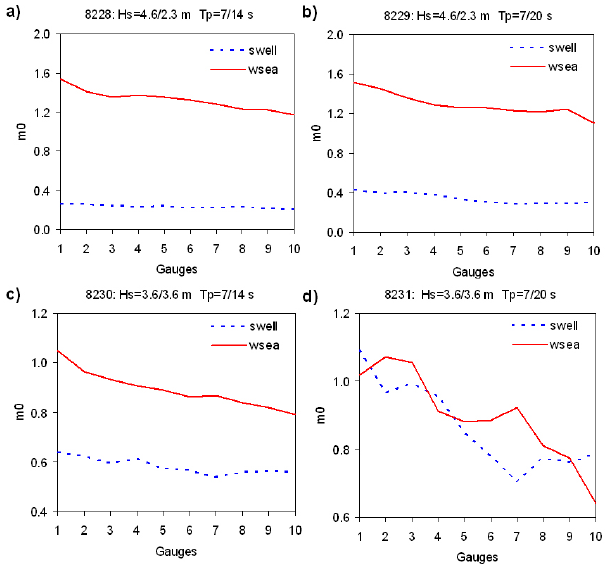
Figure 4. Following seas: variation with the distance of the spectral energies of the wind sea and swell components.